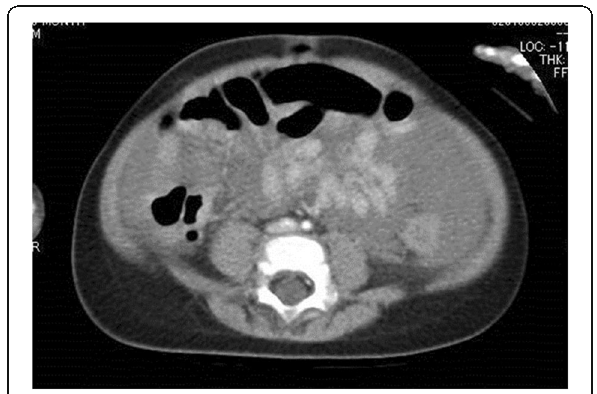
Fig. 6 Initial computed tomography (CT), case 2. CT shows massive bloody ascites